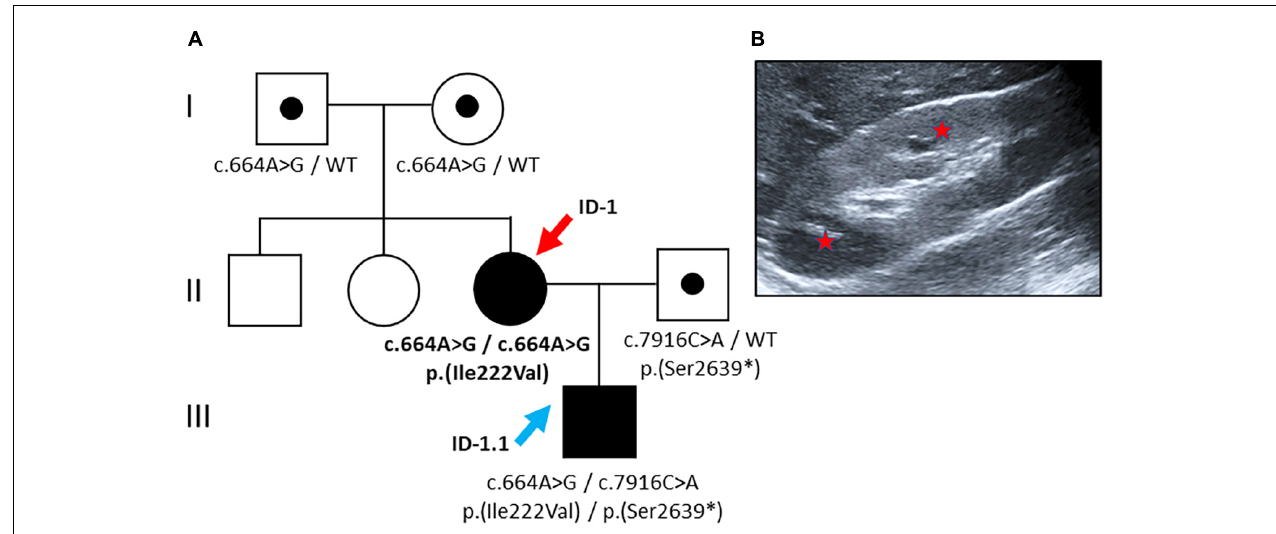
FIGURE 1 | Pedigree and renal imaging (Family 1). (A) Family pedigree: Individuals suffering from PKD are indicated as black symbols, and variant carriers are denoted with a black dot. The female index patient (red arrow) carries a homozygous missense variant [NM_138694.3: c.664A > G, p.(Ile222Val)]. Her son (blue arrow) carries compound heterozygous PKDH1 -variants: maternal missense variant plus a putative paternally transmitted pathogenic nonsense variant [NM_138694.3: c.7916C > A, p.(Ser2639 ∗ )]. WT: wild-type. (B) Kidney ultrasound of ID-1 at the age of 18 years displaying mild renal phenotype with hyperechogenic parenchyma and microcystic alterations (red stars highlight small